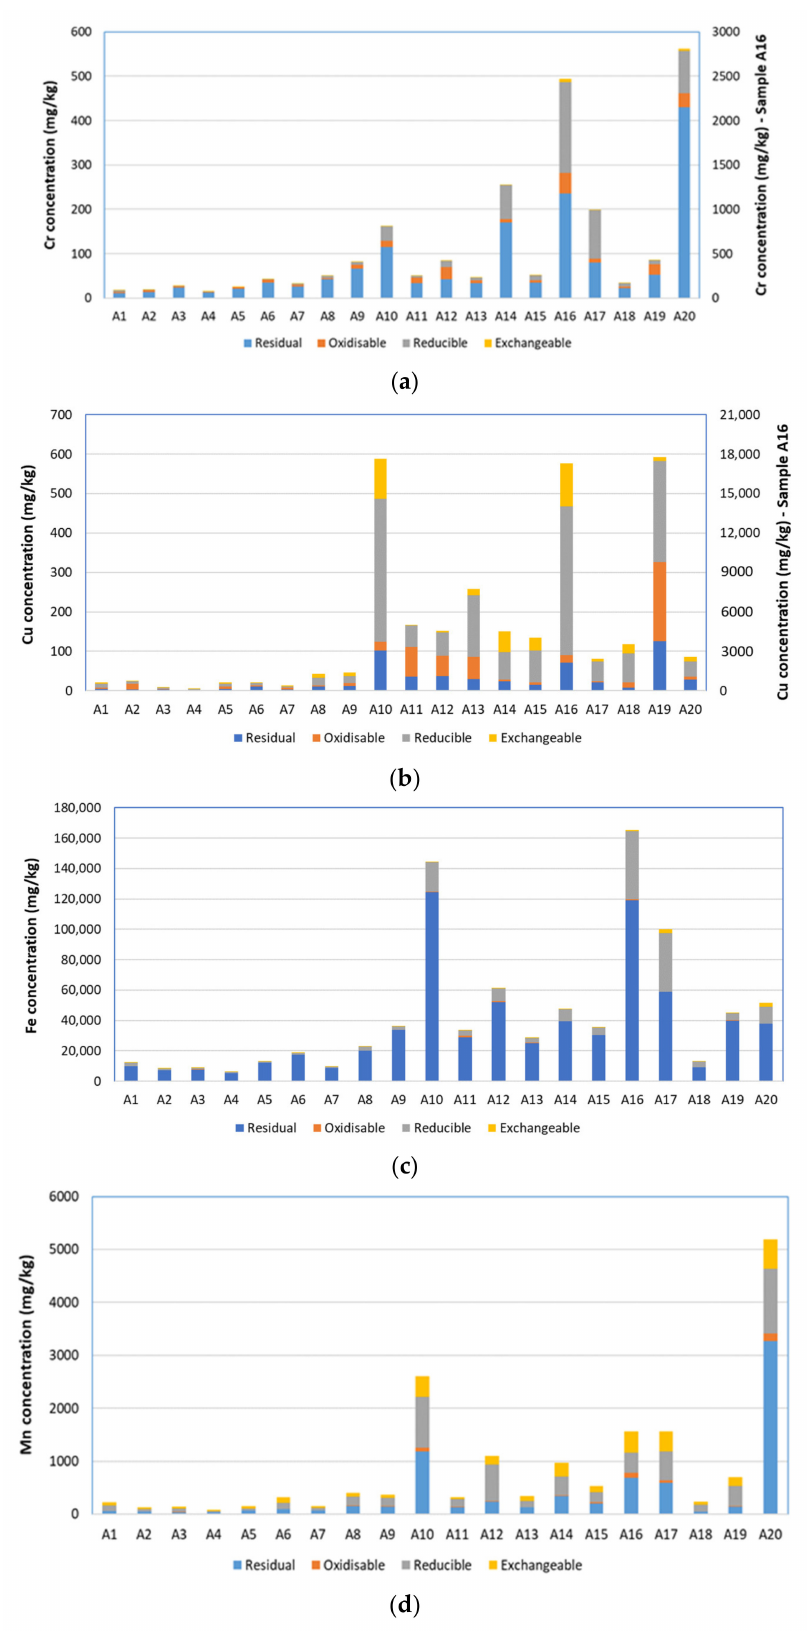
Figure 2. Fractionation of ( a ) Cr, ( b ) Cu, ( c ) Fe and ( d ) Mn according to BCR sequential extraction. Note that Cr and Cu are plotted against a secondary axis for site